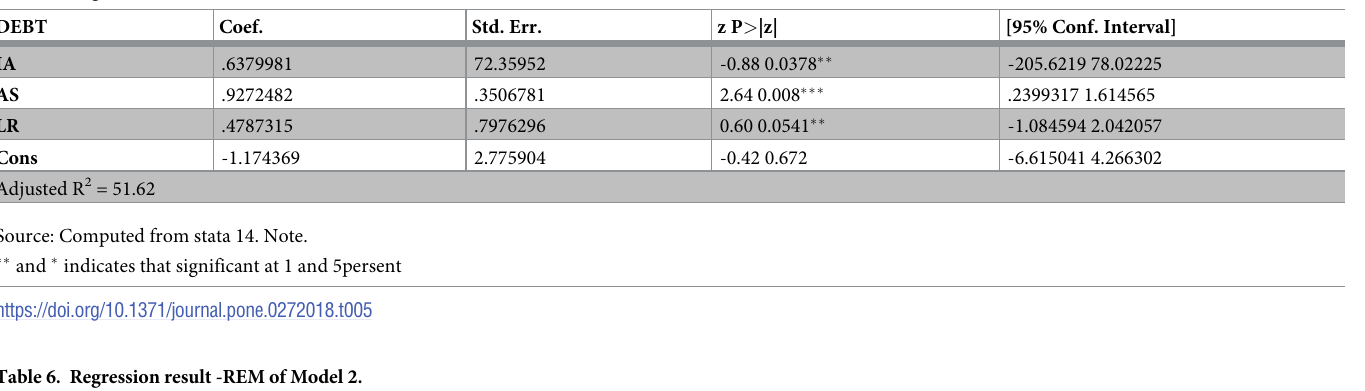
Table 5. Regression result -REM of Model 1.